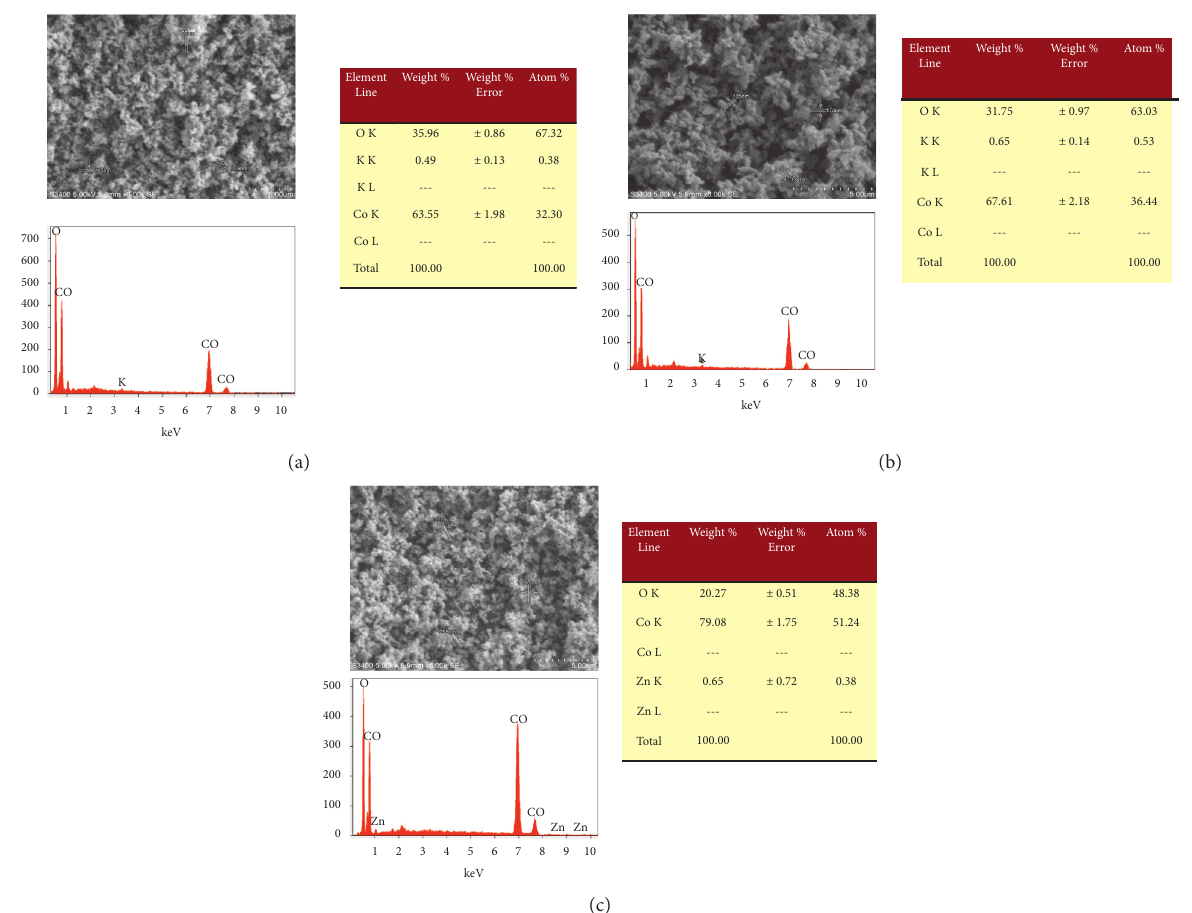
3 O 4 NPs within (a) 1: 2, (b) 1 :1, and (c) 2:1 ratio with their